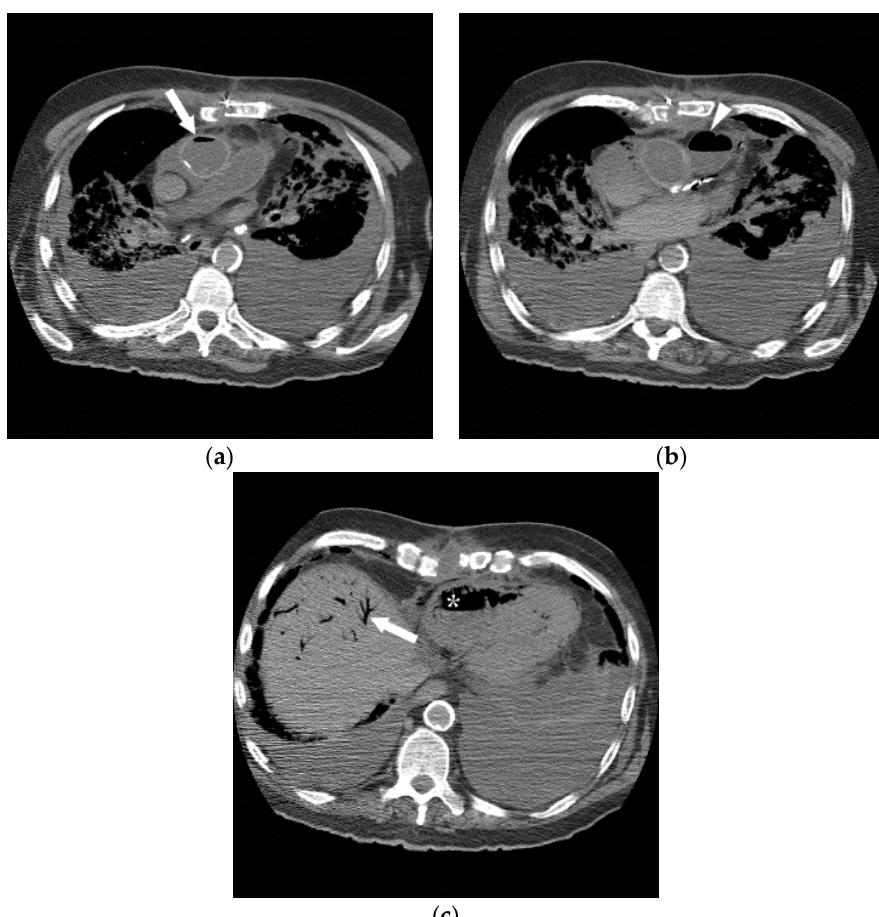
Figure 3. A 69 ‐ year ‐ old man who was critically ill with sepsis, pneumonia, and Cerebral Vascular Accident (CVA). Immediately after his pulmonary arterial line was pulled, he developed sudden cardiopulmonary arrest, suspected to be related to air embolism. A post ‐ mortem CT ( a – c ) was performed 18 h later, revealing intravascular air in the ascending aorta ( a , arrow), pulmonary artery ( b , arrowhead), right ventricle ( c , *) and the liver (arrow). Given the extent of air, it was considered most likely that the air was related to post ‐ mortem state. Despite these findings, even when the heart was opened under water at autopsy, no air escaped, highlighting the difficulty in diagnosis of air embolism in some cases.